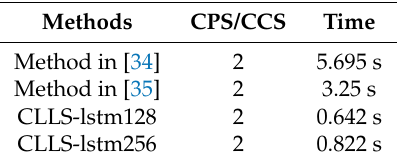
Table 4. The average time of generating the same number of words. CPS, candidate pool size; CSS, candidate character set size; CLLS, character-level linguistic steganographic